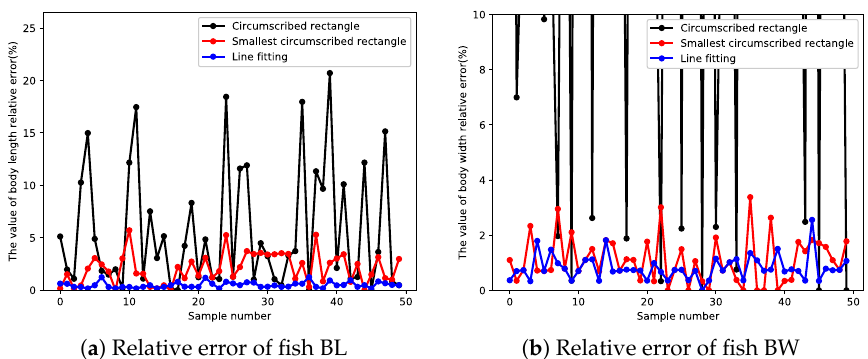
Figure 18. Comparison of relative measurement errors using U-net combined with three measure- ment methods.